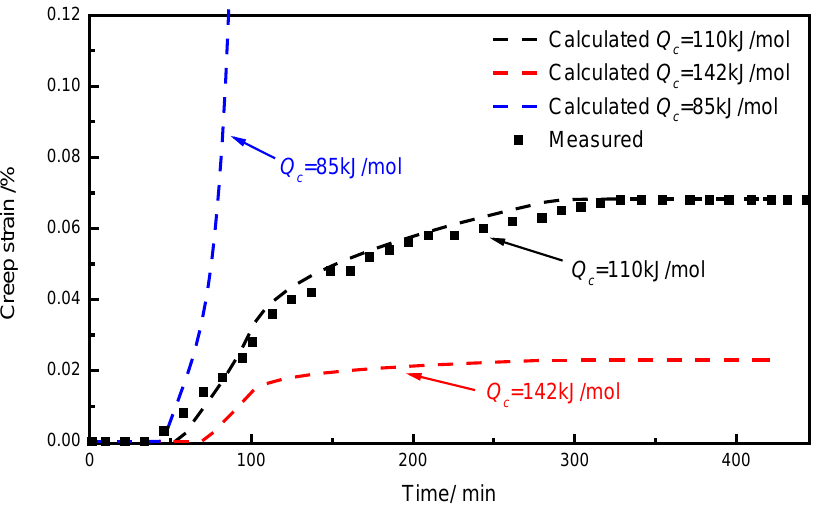
Figure 14. Sensitivity analysis of apparent activation energy Q c on creep strain.